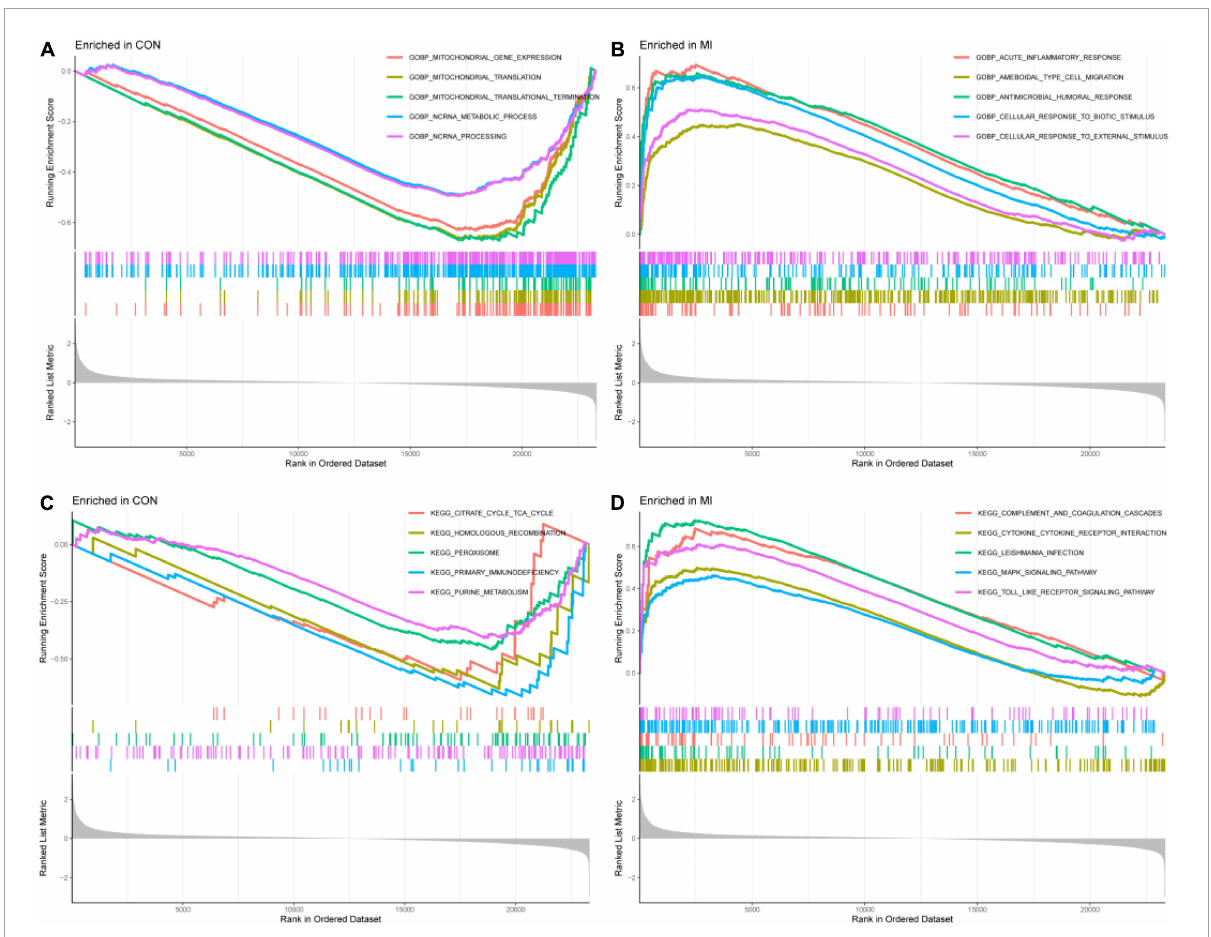
FIGURE5 The results of GSEA. (A,B) The GSEA results from the GSE66360 dataset in GO analysis. (C,D) The GSEA results from the GSE66360 dataset in KEGG analysis.